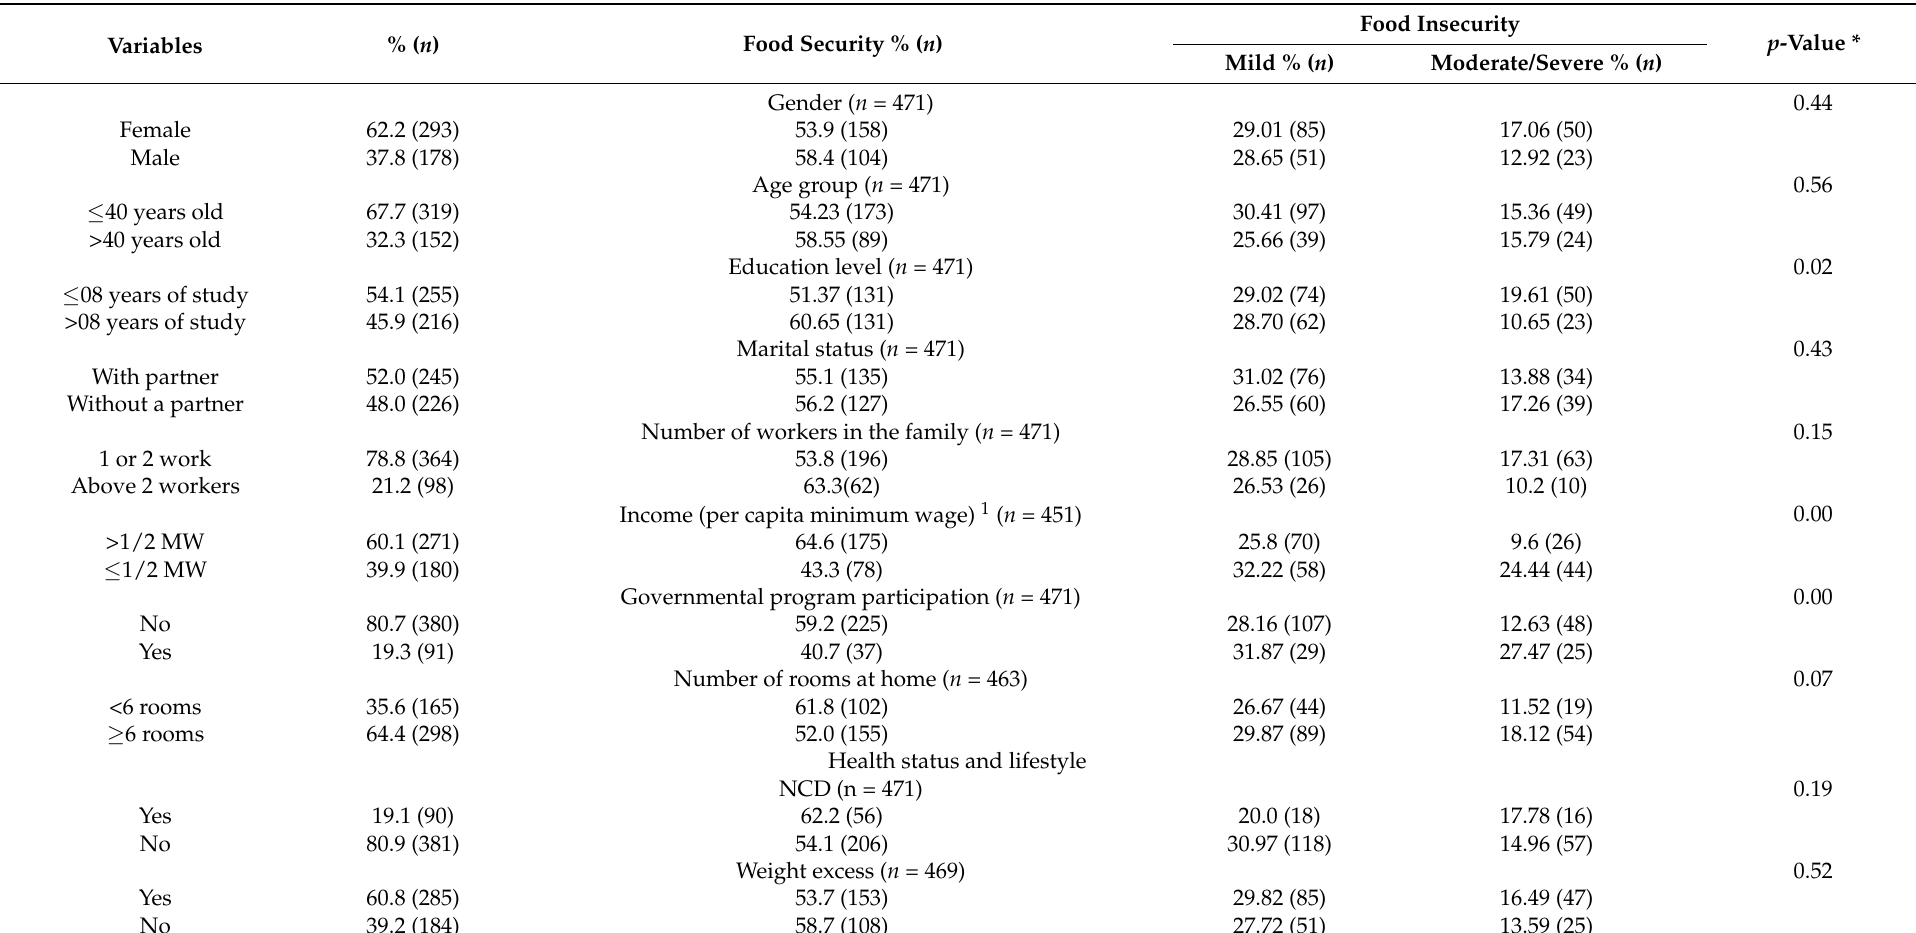
Table 1. Descriptive analysis of the study population, considering the distribution in Household Food Security Situation of demographic, socioeconomic characteristics, health status and lifestyle, and work-related